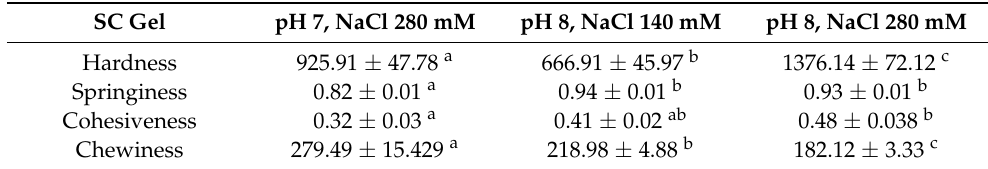
Table 4. Results of texture profile analysis of skin collagen (SC) gels from C. idella under different salinity and pH conditions.